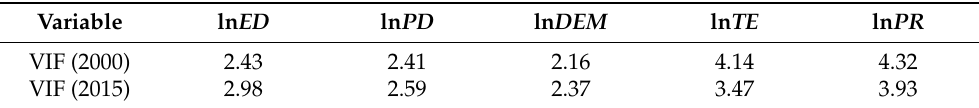
Figure 3. Spatial correlation between EFL proportion and urban economic density (ED) in 2000 and 2015. Table 2. Results of the variance inflation factor